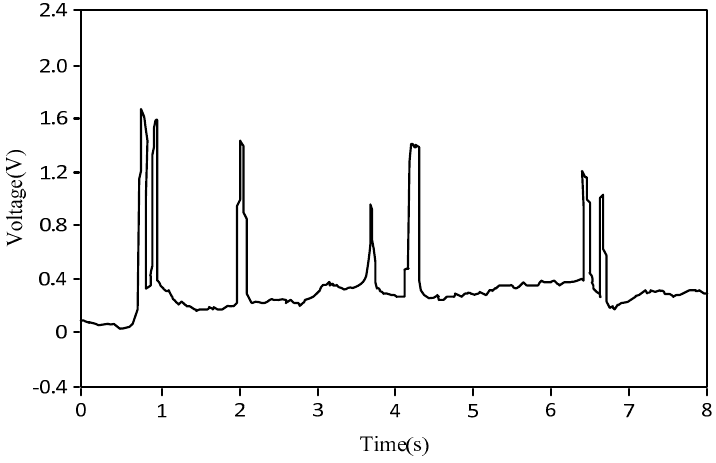
Figure 9. Graph of annular flow or fine-beam annular flow.